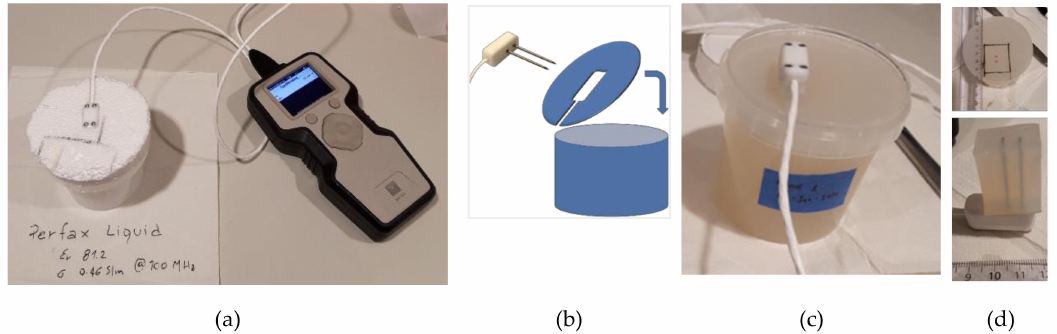
Figure 1. Measurement set up. ( a ) Photography showing that the thermal property analyzer is connected to the sensor; the sensor is immersed in the high-viscosity phantom and held in place by a dedicated fixture. ( b ) Sketch of the fixture showing the opening where the sensor is placed. ( c ) Without fixture. ( d ) Top: the dimension of the sample where decreased keeping fixed the sensor position; bottom: the S4 sample, i.e., the sample with 8 mm of material parallel to the sensor in all directions.